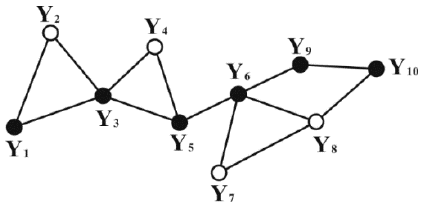
Figure 3. Determination of the unfolded distance between instances.